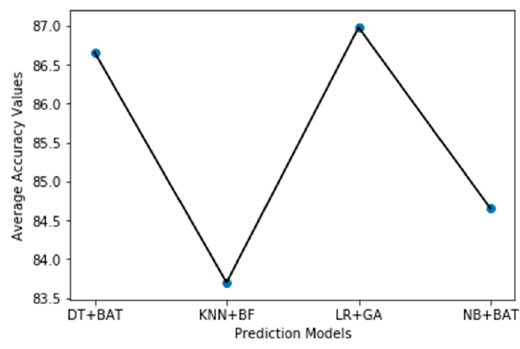
Figure 3. Prediction Models with the Highest Variation.